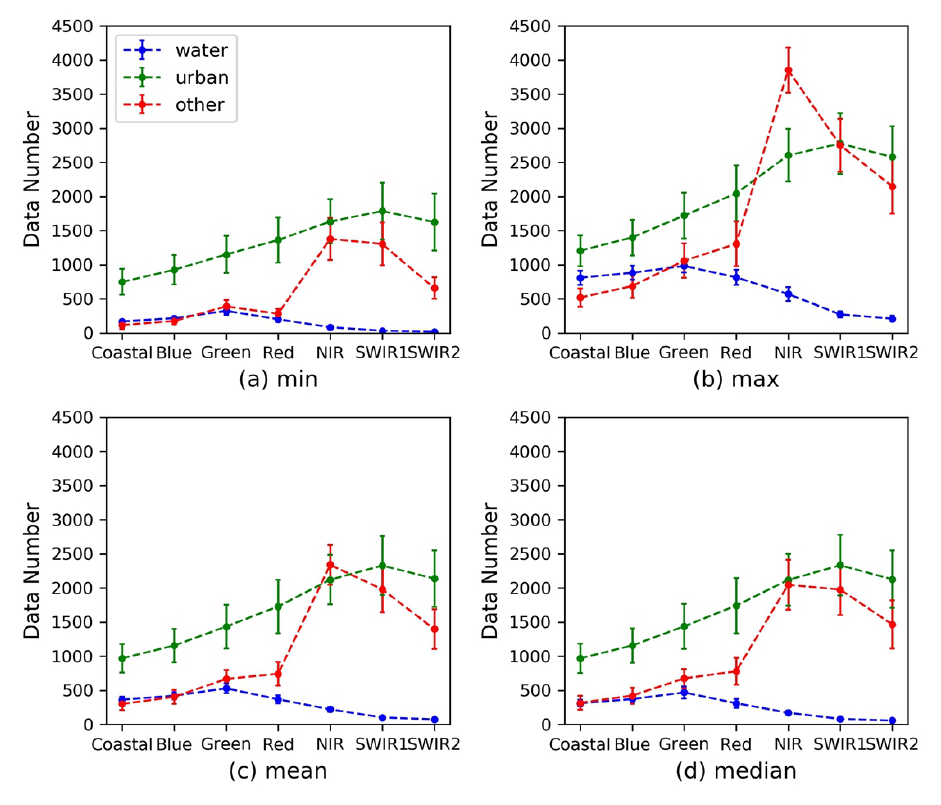
Figure 4. Characteristic mean line chart